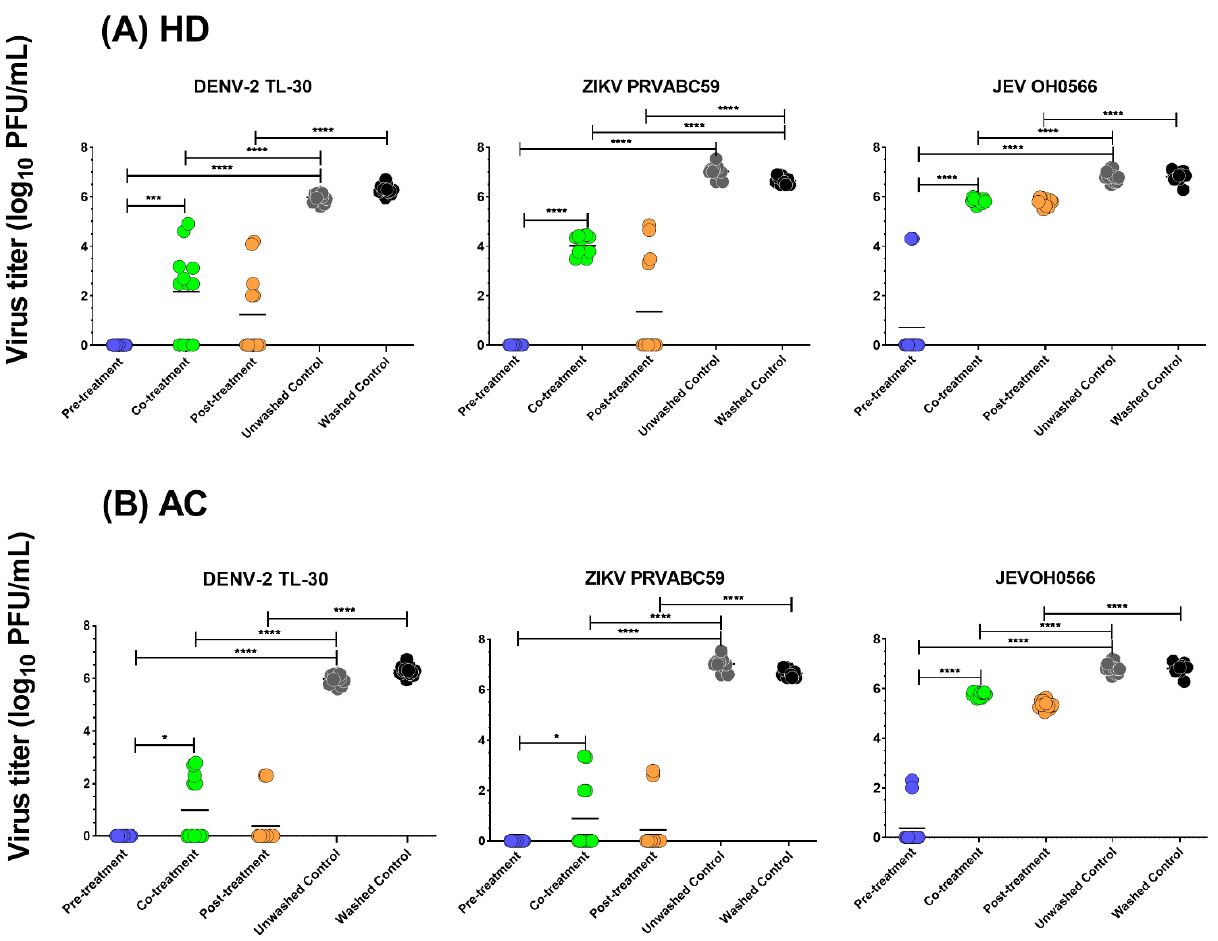
Figure 4. Efficacy of Hedyotis diffusa (HD) and Artemisia capillaris (AC) at 5 mg/mL concentration against JEV, ZIKV, and DENV-2 at an MOI of 0.01 in Vero cells, as quantified by plaque assay in pre-, co-, and post-treatment studies. Log 10 transformed viral titer values of herb-treated viral-infected cell culture supernatants were compared with that of the untreated viral-infected control. (1) Pre-treatment process ( − 1 h p.i.): Vero cells were treated with herbs at a concentration of 5 mg/mL at 1 h prior to viral infection; (2) co-treatment process (0 h p.i.): Vero were treated with herbs at 5 mg/mL during virus infection; (3) post-treatment process (1 h p.i.): Vero 9013 cells were infected with virus for 1 h, viral inoculum was aspirated, cells were washed with EMEM twice and replaced with EMEM with 10% FBS. ( A ) viral titer analysis following HD treatment. ( B ) Inhibition in AC treated samples. The error bars represent the standard deviation of the mean of 12 replicates; * p < 0.05; ** p < 0.01; *** p < 0.001; **** p < 0.0001. Table 3. Inhibition of HD and AC on viral replication in pre-, co-, and post-treatment processes. HD AC HD